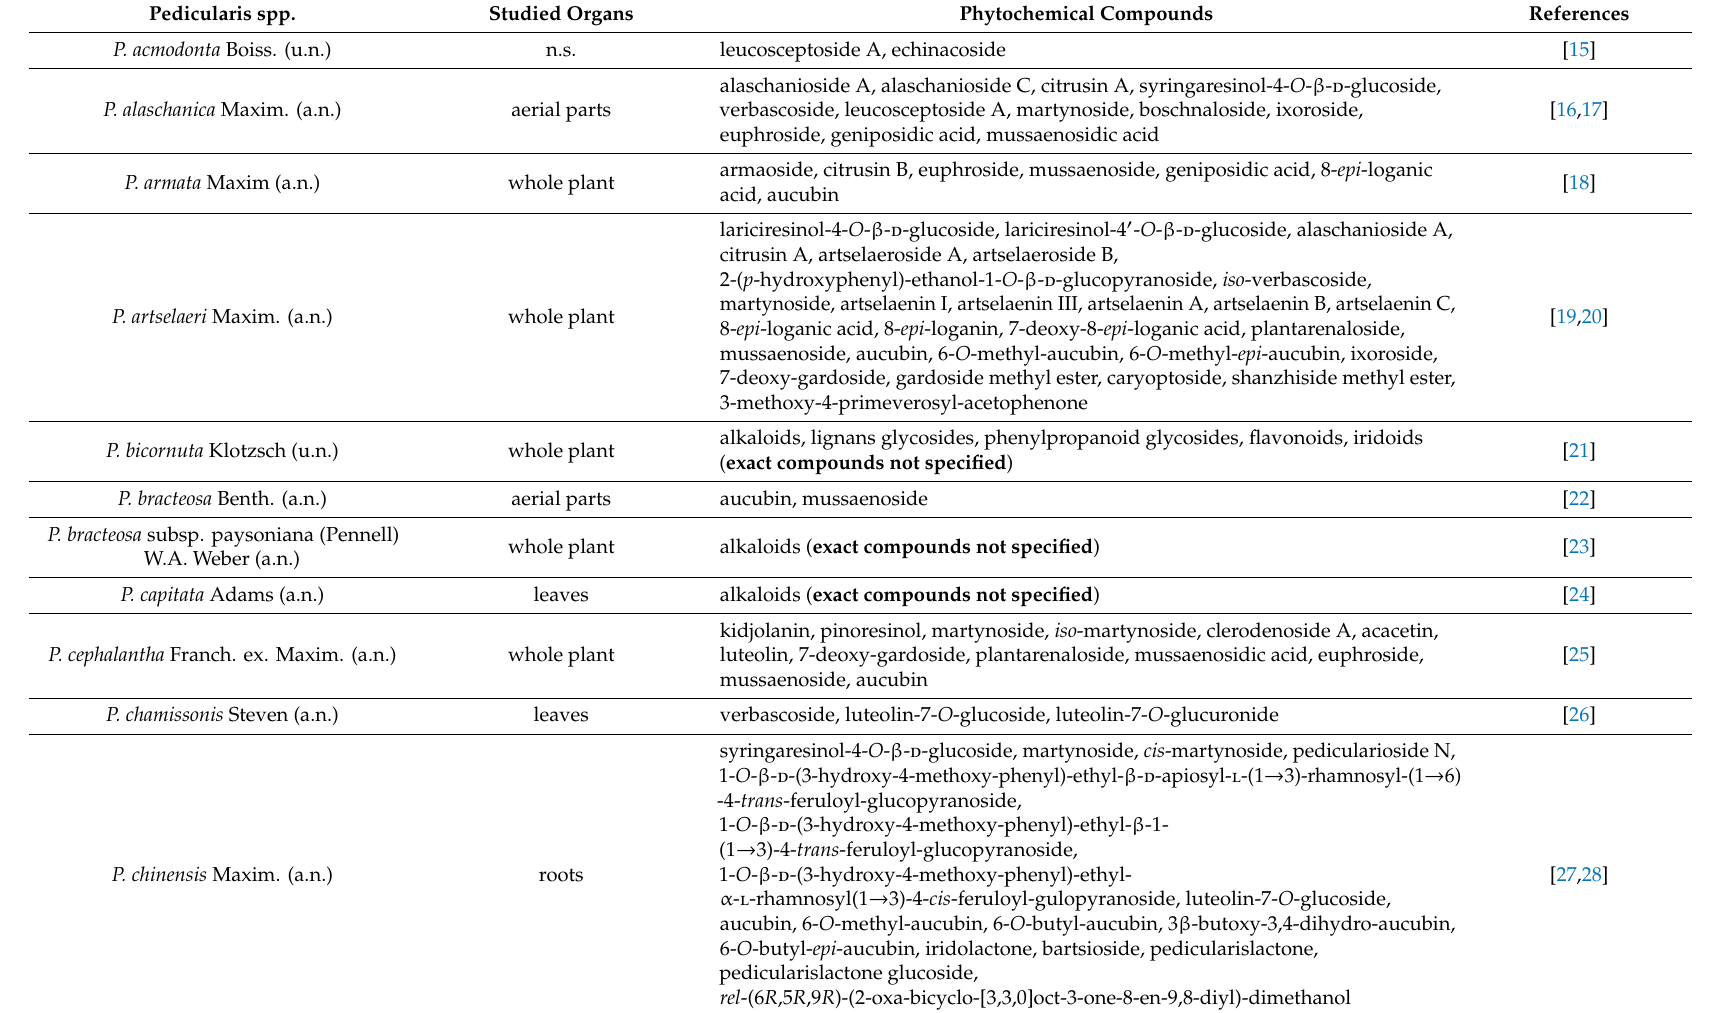
Table 1. Phytochemical Compounds Reported in the Studied Pedicularis